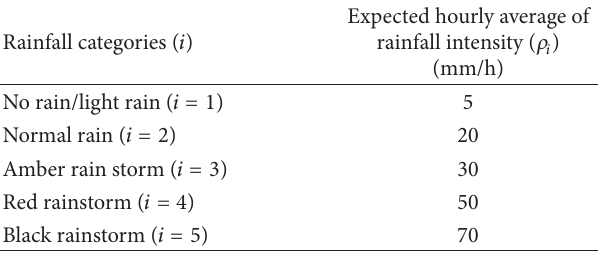
Table 1: Rainfall category adopted in the weather